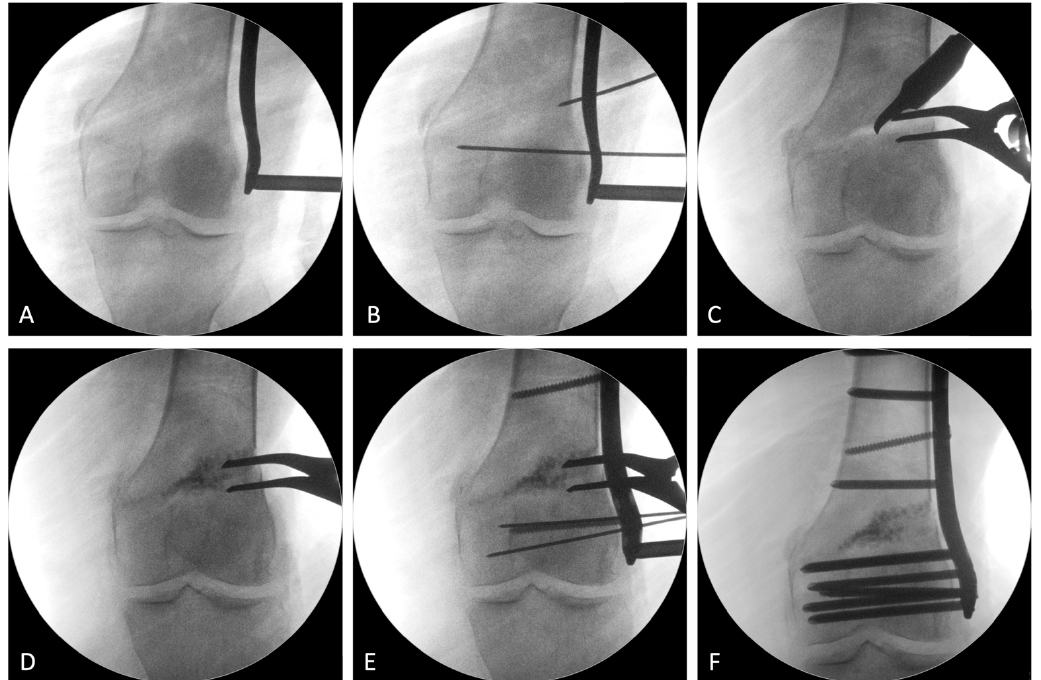
Figure 4. The fluoroscopy images show the operative steps. ( A ) The placement of Synthes LISS locking plate. ( B ) Pin was inserted from lateral femoral condyle toward medial femoral condyle. ( C )